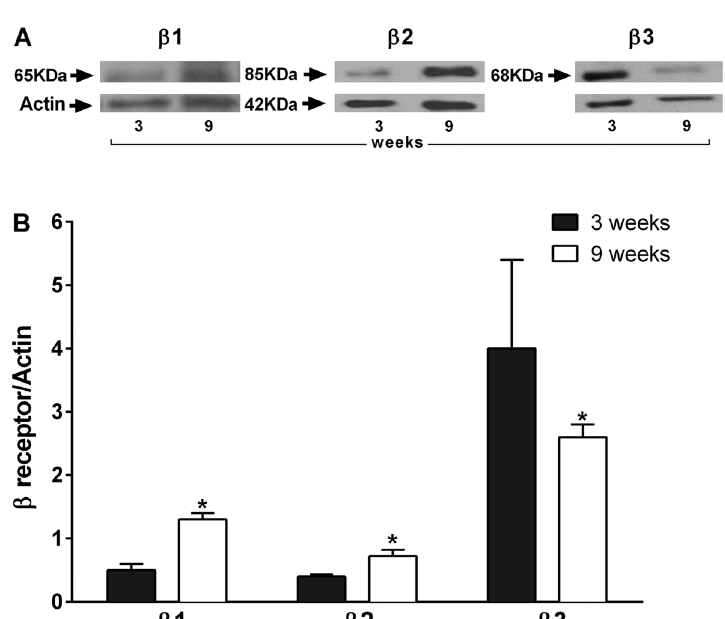
Figure 3. Concentration response curves in pre- contracted (treated with phenylephrine) aortic rings. The relaxant response to BRL3744 was evaluated in endothelium-intact aortic rings ( + ) and endothelium-denuded aortic rings ( (cid:2) ) ( A and C ) of 3- and 9-week-old rats ( B and D ) in the absence or presence of the b 1 receptor antag- onist CGP20712A (10 -7 M), b 2 receptor antagonist ICI118551 (10 -7 M), and b 3 receptor antagonist SR59230A (10 -7 M). Data are reported as the mean ± SE of 5 different animals. *P o 0.05 vs control (ANOVA followed by modi fi ed Newman Keuls t -test).